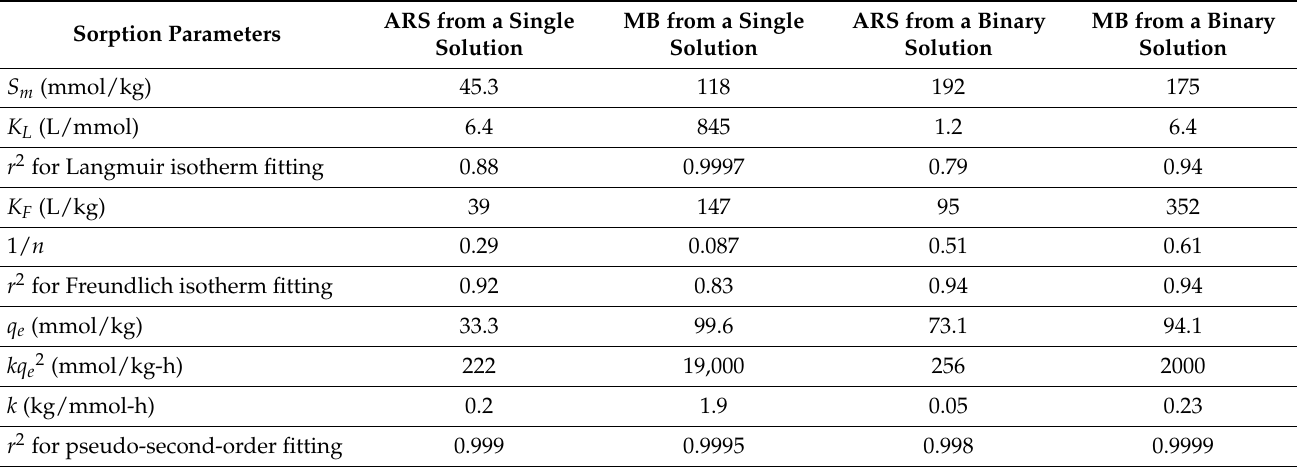
Table 1. Sorption parameters of ARS and MB on the HNC for the isotherm and kinetic